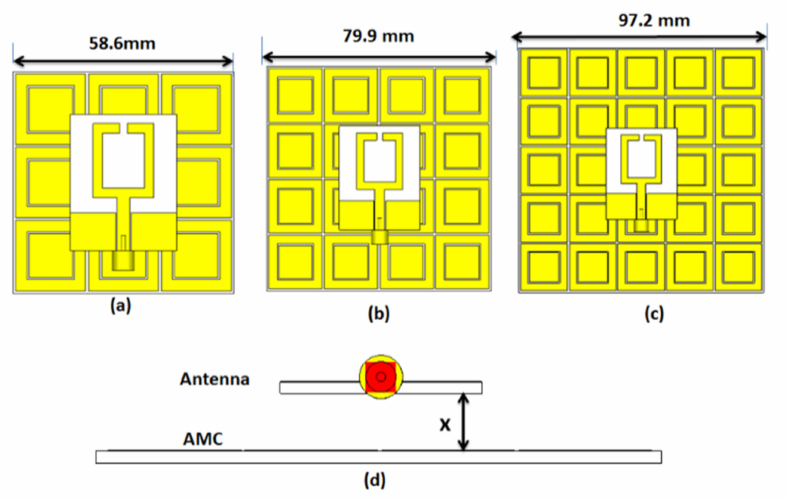
Figure 10. Proposed antenna with AMC with different integration sizes: ( a ) 3 × 3; ( b ) 4 × 4; ( c ) 5 × 5; ( d ) top view.